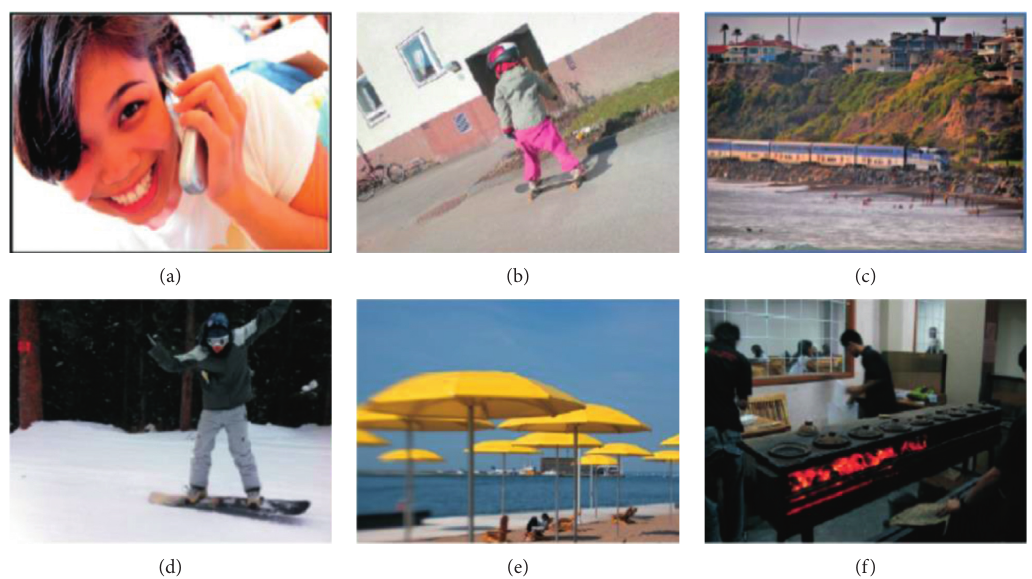
Figure 5: Test of the multimedia image selected for the comparison of algorithm effects. (a) Life image (chat on the phone). (b) Sports image (skateboarding on the street). (c) Traffic image (a train by the river). (d) Sports image (skiing). (e) Life image (beach). (f) Lifestyle image